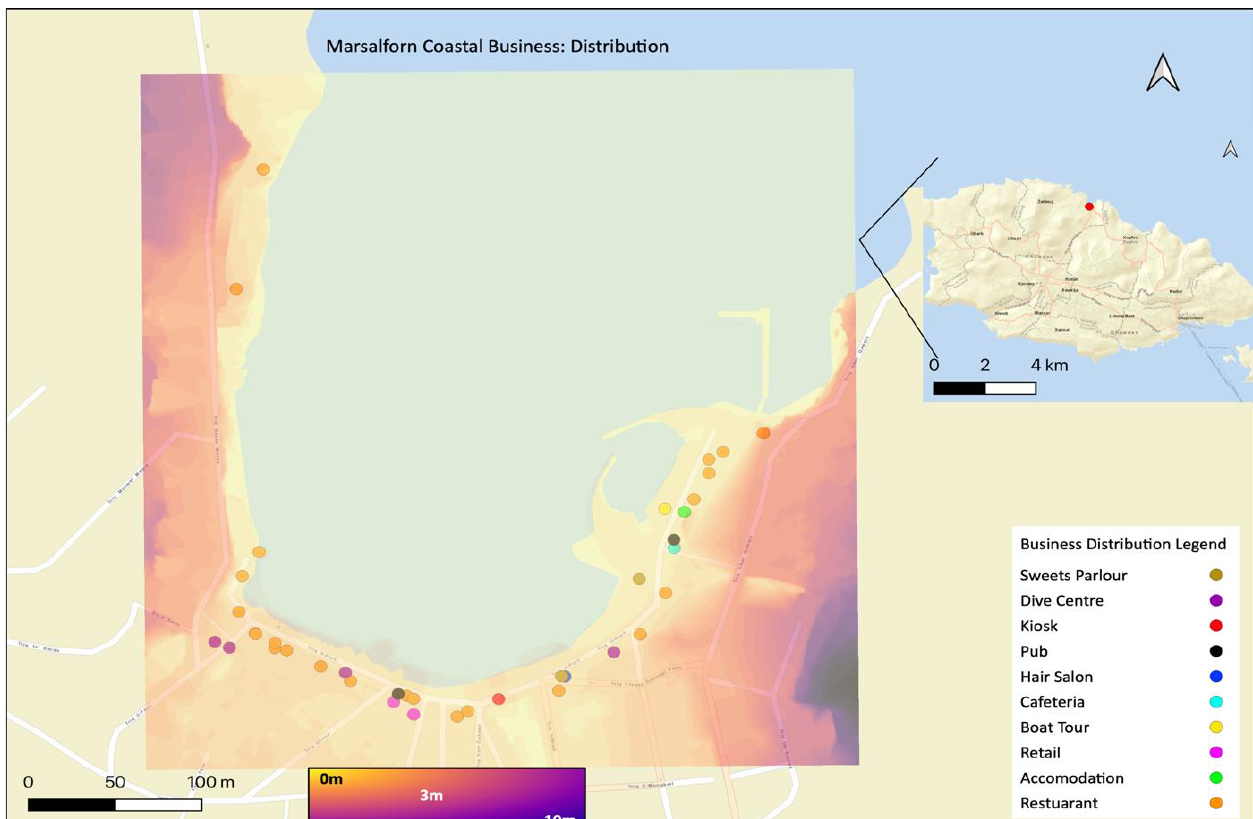
Figure 11. Marsalforn’s coastal businesses’ distribution.